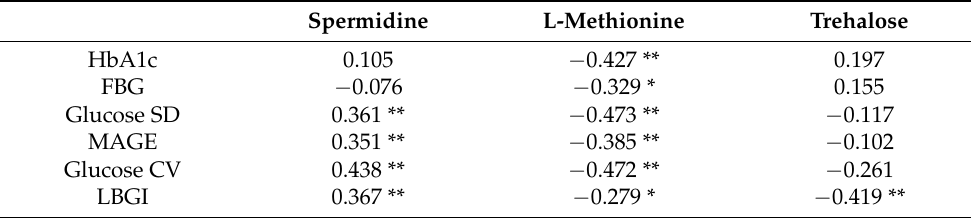
Table 3. Correlation of selected biomarkers with glycemic parameters in all subjects (r).